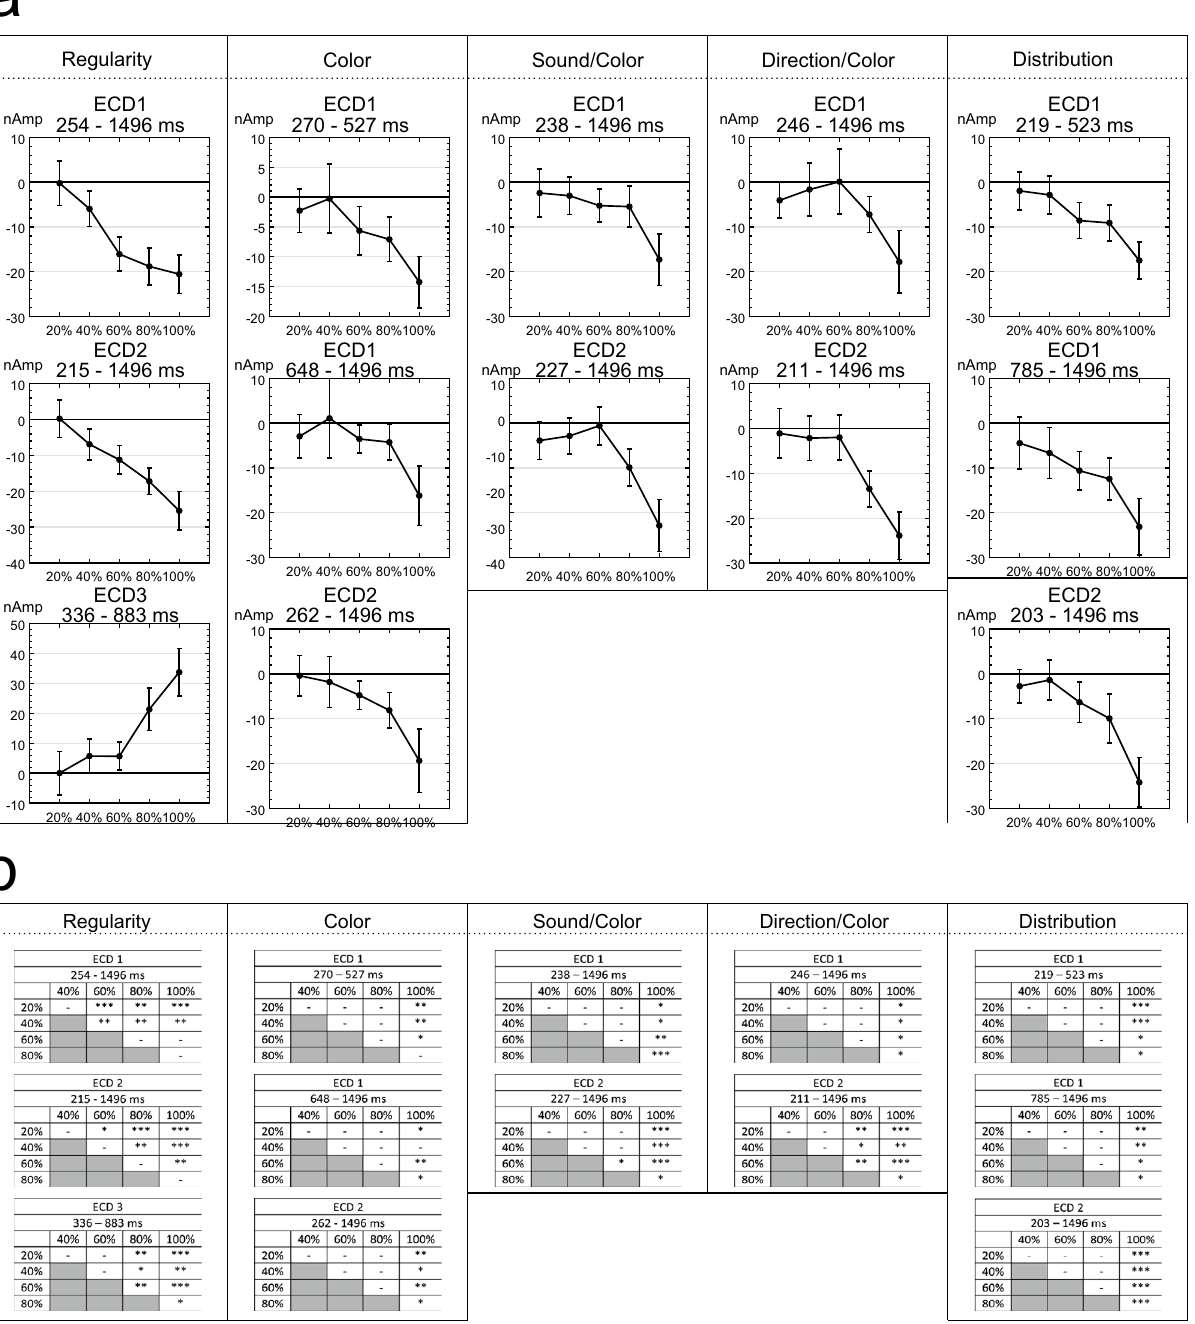
Figure 7. Mean activity in intervals and results of post-hoc testing. ( a ) Mean source activity averaged over latencies demonstrating significant main effects of PSYMM for each task and ECD. Error bars represent 95% within-subject confidence intervals. ( b ) Results of post-hoc permutation-based t test for each significant latency interval (*P < 0.05; **P < 0.01; ***P <